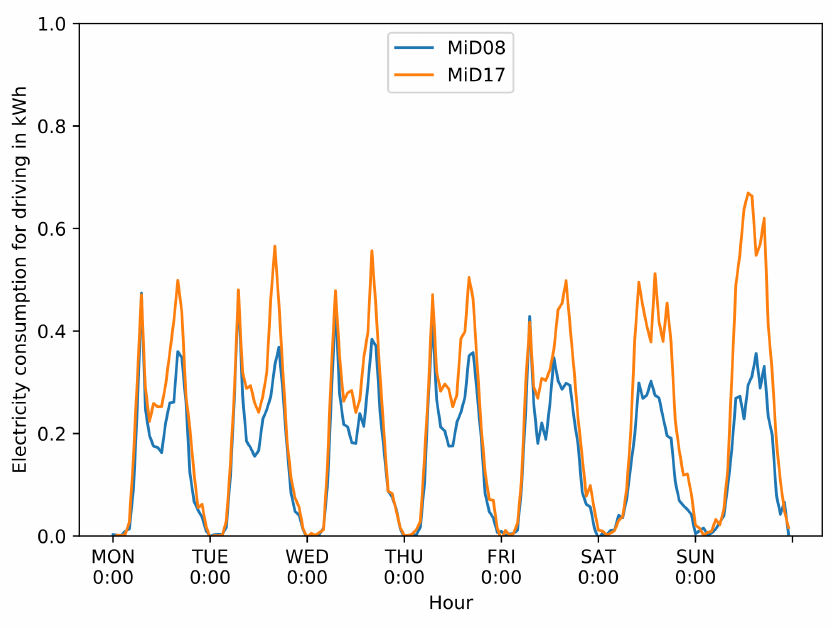
Figure 4. Weighted average electricity consumption for driving differentiated by